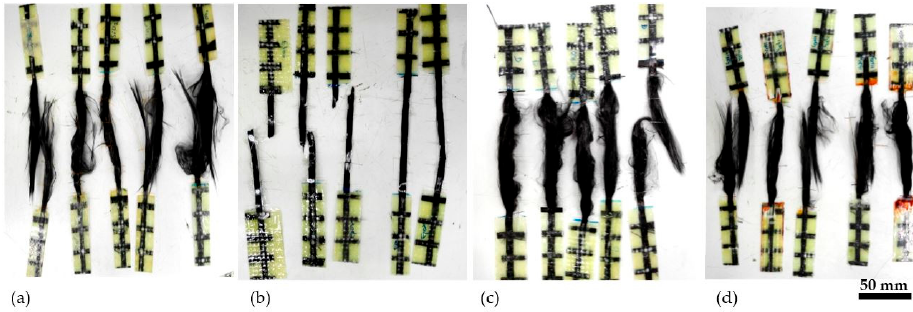
Figure 4. Failure modes: ( a ) C-Dry_Ref, ( b ) C-E-Ref, ( c ) C-NS_Ref, ( d ) C-Ox_Ref.